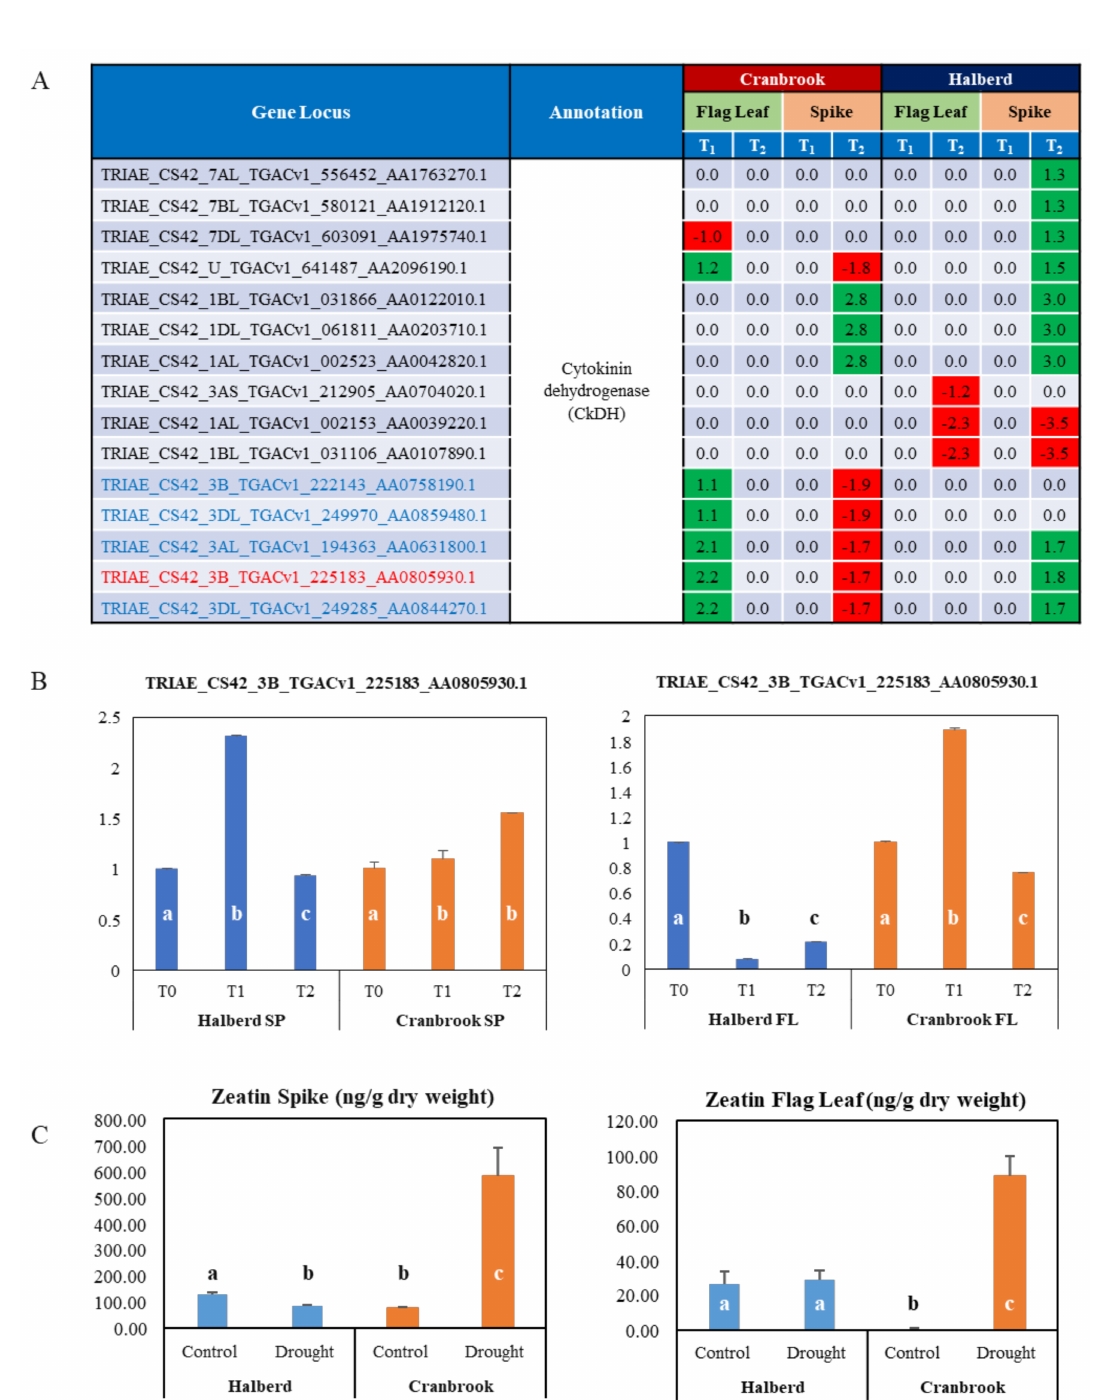
Figure 9. ( A ) Expression data for 15 enriched genes encoding cytokinin dehydrogenase (CkDH). Gene loci in blue and red are specifically enriched in Halberd and Cranbrook, loci in purple are enriched in both wheat lines. The expression data are listed as Log FC values relative to unstressed plants (green = up-regulated; red = down-regulated). ( B ) Expression analysis of one candidate TaCkDH gene. Three repeat samples were tested, and expression data are relative to unstressed control expression levels (=1). Error bars show standard errors. FL = flag leaf; SP = spike. Gene expression levels are relative to the unstressed control (=1) for each wheat line and bars in the graph labelled with different letters are significantly different ( t -test; p < 0.05). ( C ) Measurement of zeatin levels in control and drought-stressed Halberd and Cranbrook flag leaves and spikes. Average ABA levels are expressed in ng/g dry weight (Y-axis). Three repeats were used for each measurement and error bars are standard errors. Zeatin levels that are significantly different compared the Halberd unstressed control and compared to the other samples in the graph are labelled with different letters ( t -test; p <